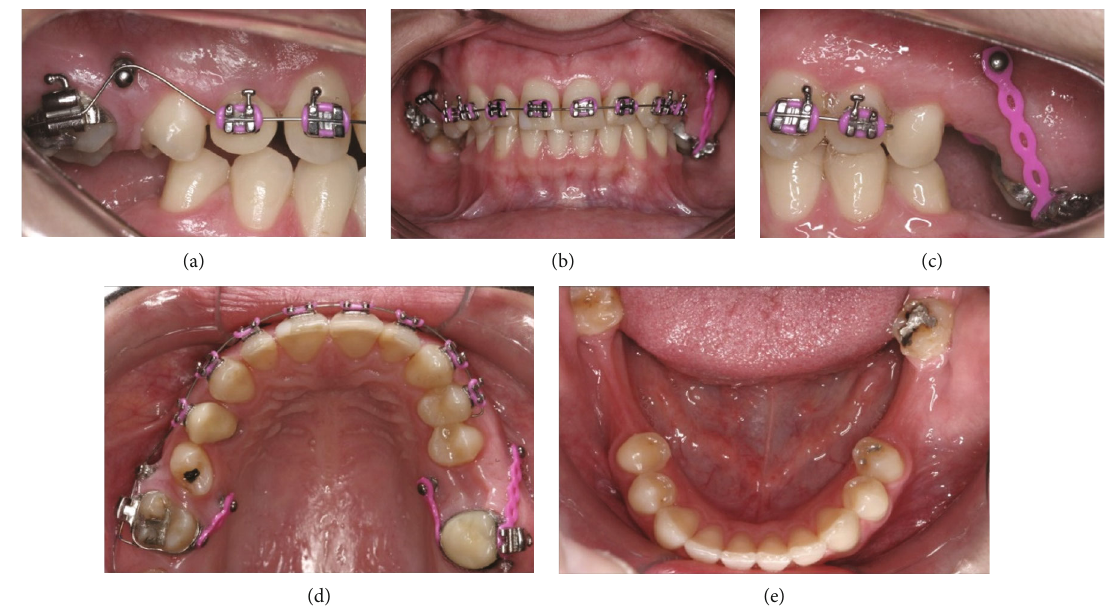
Figure 4: Progress starting the intrusion of maxillary left molars.